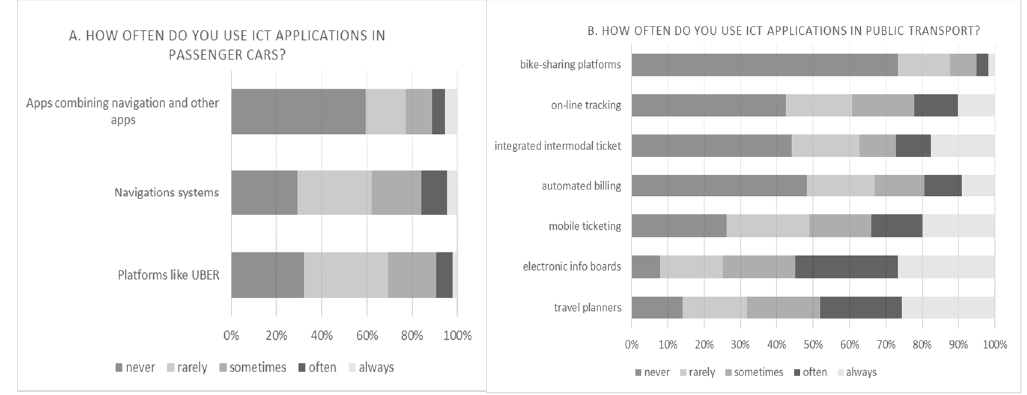
Figure 3. The frequency of ICT use (RQ2 and RQ3): ( A ) ICTs in passenger cars, ( B ) ICTs in public transport.